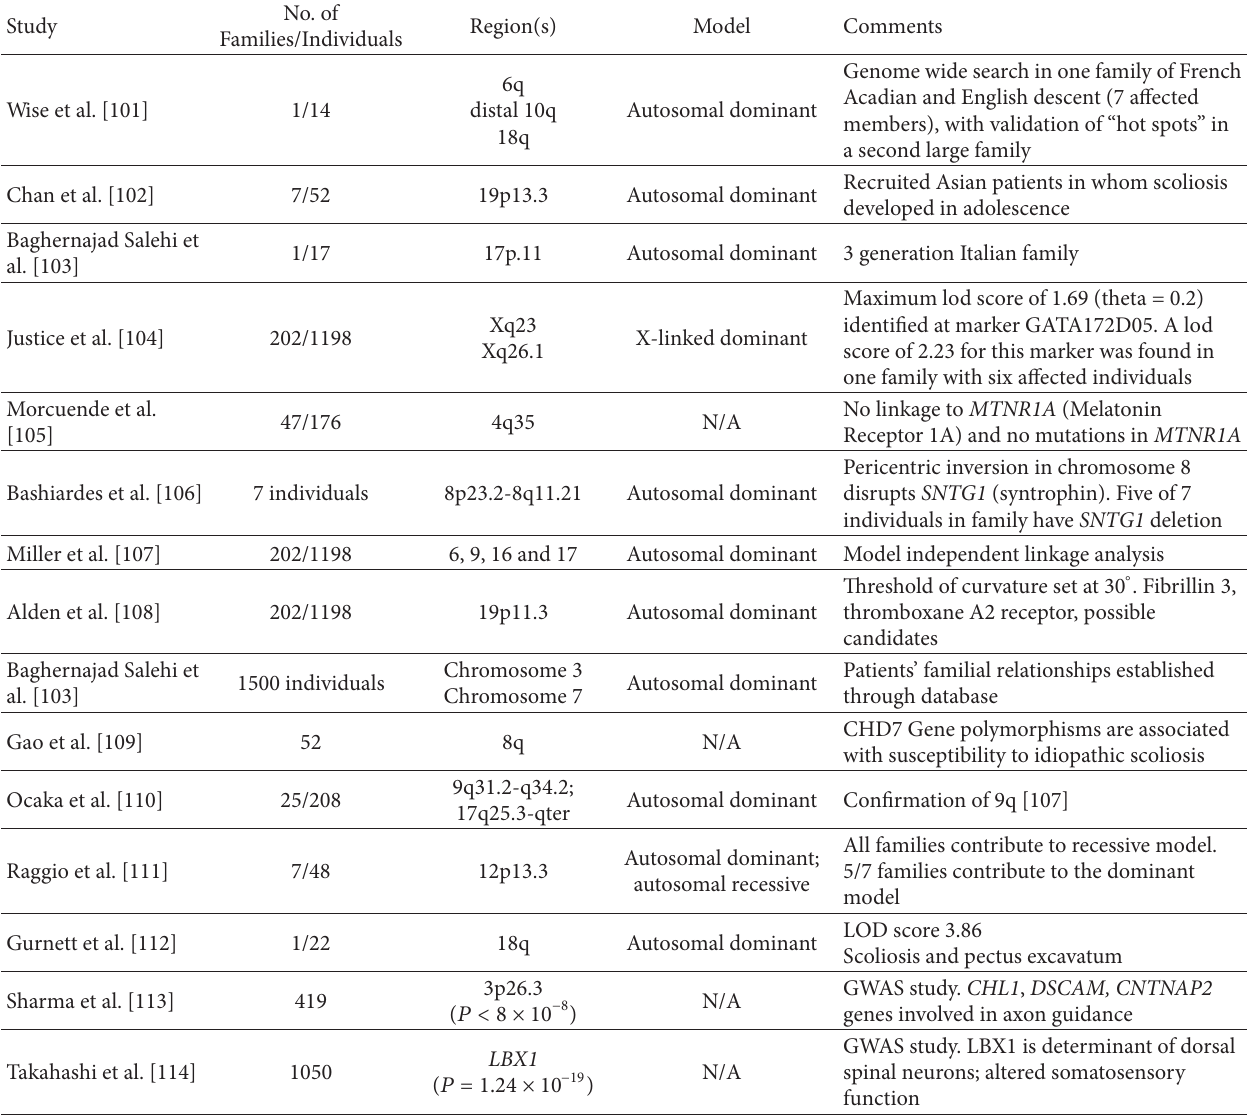
T 2: Summary of prior genetic linkage studies for